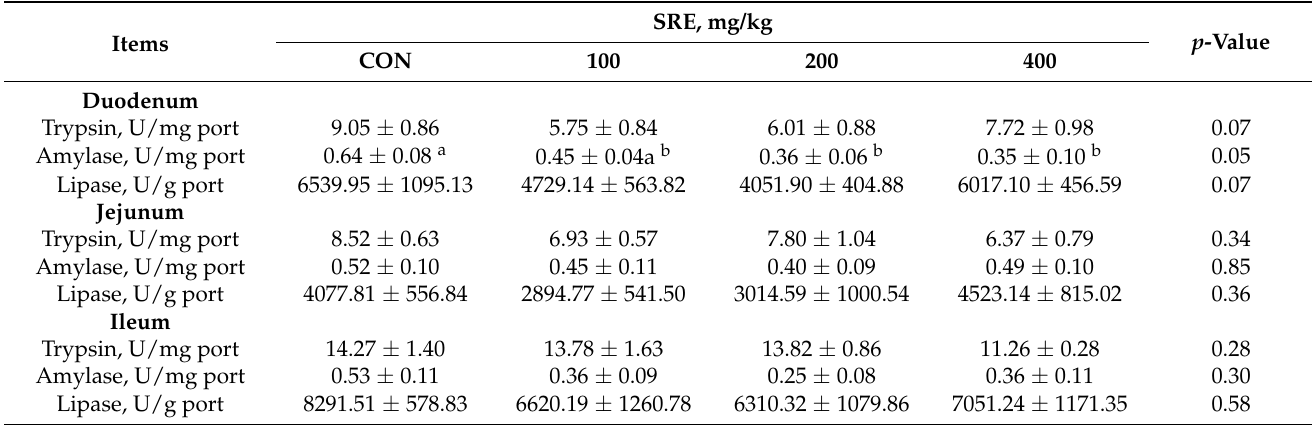
Table 6. Effects of supplementation with stevia residue extract in the diet on the small intestinal enzyme activity of weaned piglets on day 42 of the trial (a)